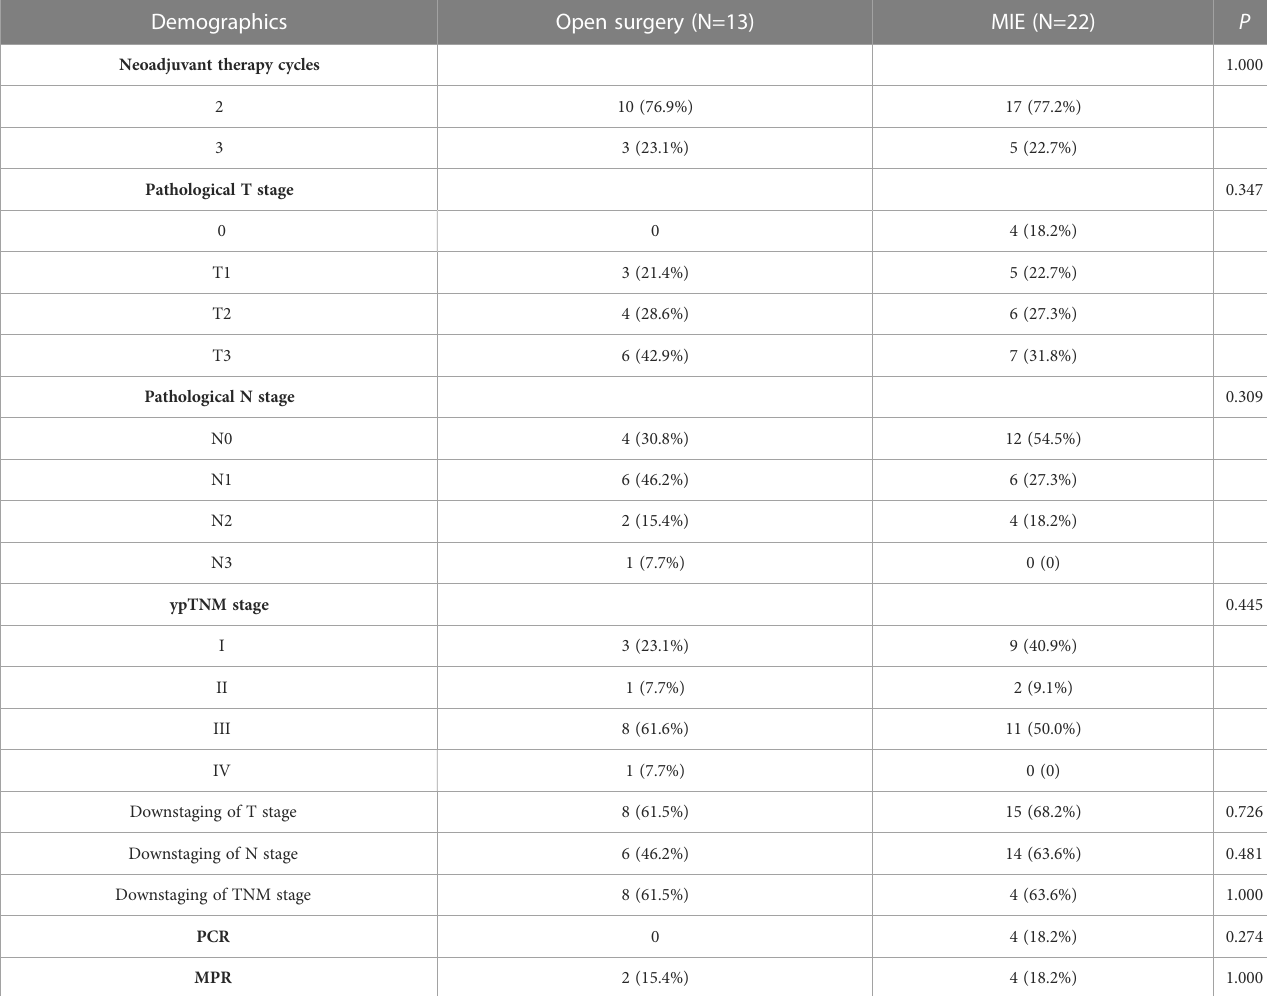
TABLE 3 Pathological stage after neoadjuvant treatment of patients strati fi ed by the surgical approach.